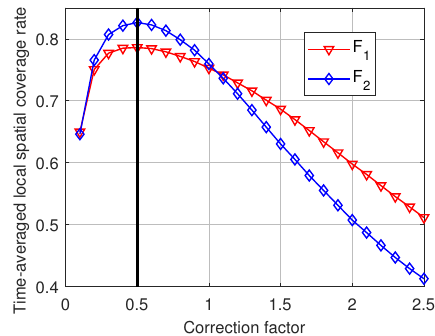
Figure 6. Variation of the time-averaged local spatial coverage rate (TLSCR) for LAs (F 1 and F 2 , shown in Figure 4) as the correction factor ( η ). The vertical line indicates the correction factor corresponding to yielding the maximum